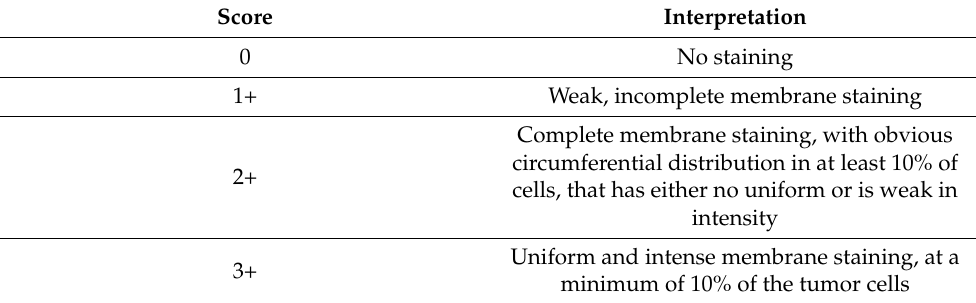
Table 3. HER2 immunocytochemistry scoring criteria.